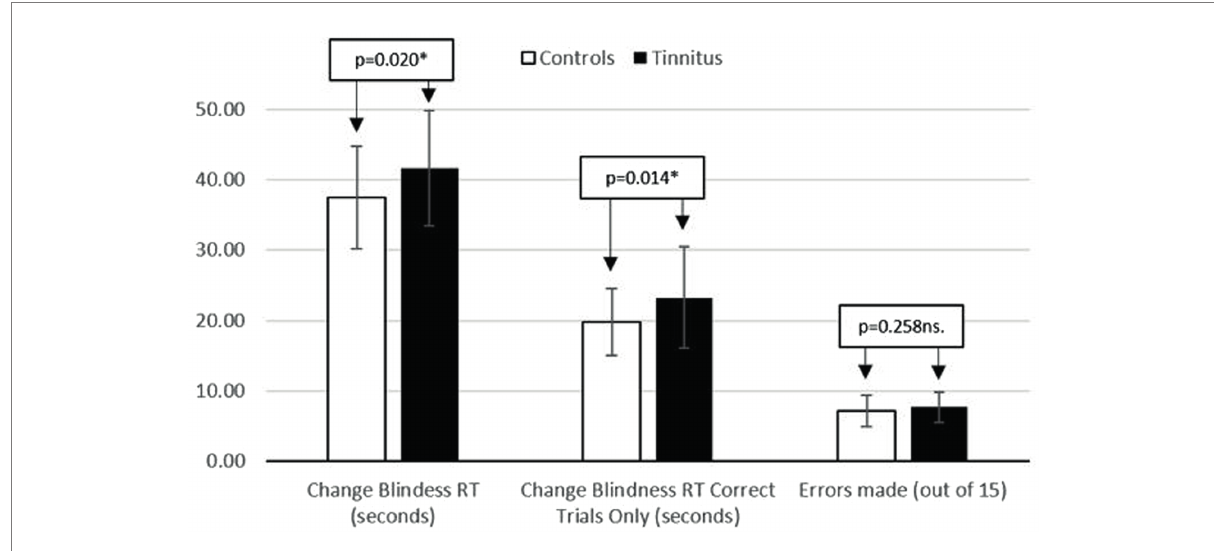
FIGURE 3 Displaying reaction time (seconds) and number of errors made during the change bilndness